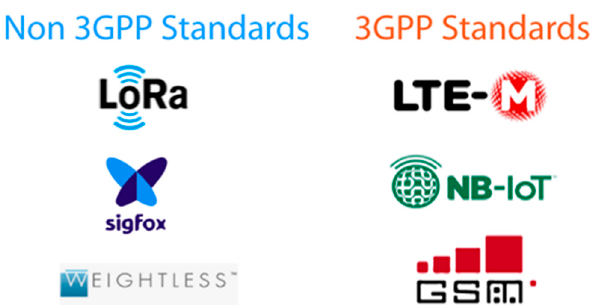
Figure 3. Classification of Internet-of-Things (IoT) communication technologies from the 3rd Generation Partnership Project (3GPP) perspective [17].